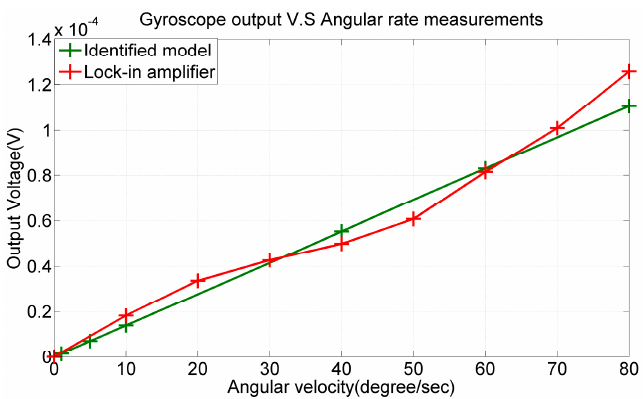
Figure 18. Output voltage versus angular rate. Sensitivity and nonlinearity from the experimental data were 1.82 μ V/deg/s and 9.5% FSO, respectively.